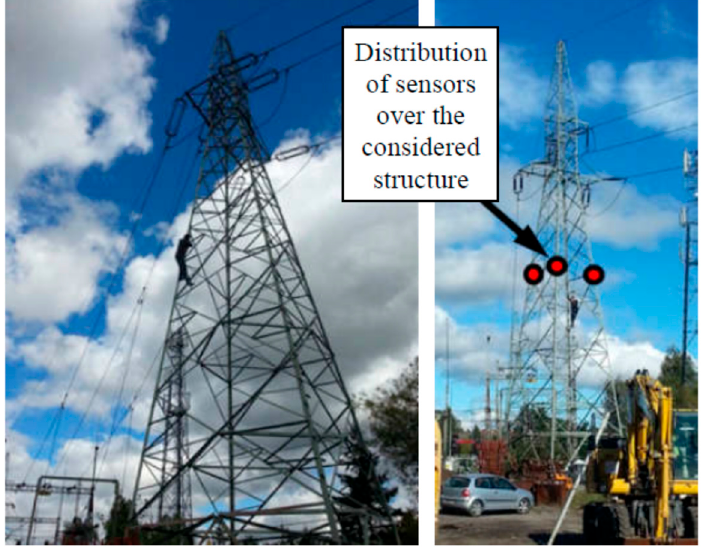
Figure 1. Considered B2-type support of the overhead, high-voltage transmission line ( left ) and distribution of sensors over the considered structure ( right ).